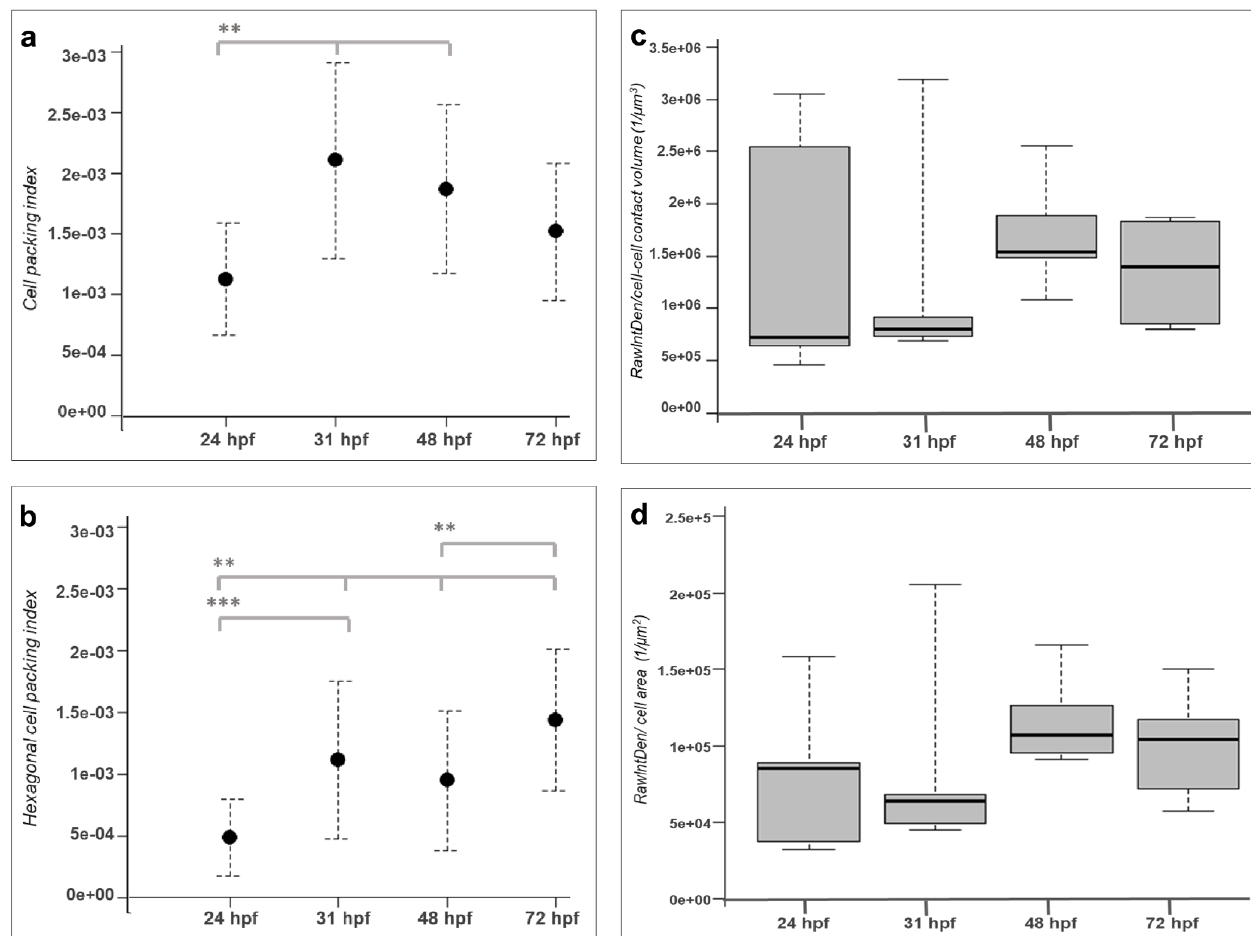
Figure 4. E-cadh expression profile in individual cells of the enveloping layer (EVL). a ) Plot of means of cell packing index calculated as the average number of cells/µm 2 ; b ) Plot of means of hexagonal cell packing index calculated as the average number of hexagonal cells/µm 2 ); c ) Box-plot of means of RawIntDen/cell-cell contact volume; d ) Box-plot of means of RawIntDen/average cell area. Statistical significances, ** p<0.01, ***p<0.001.